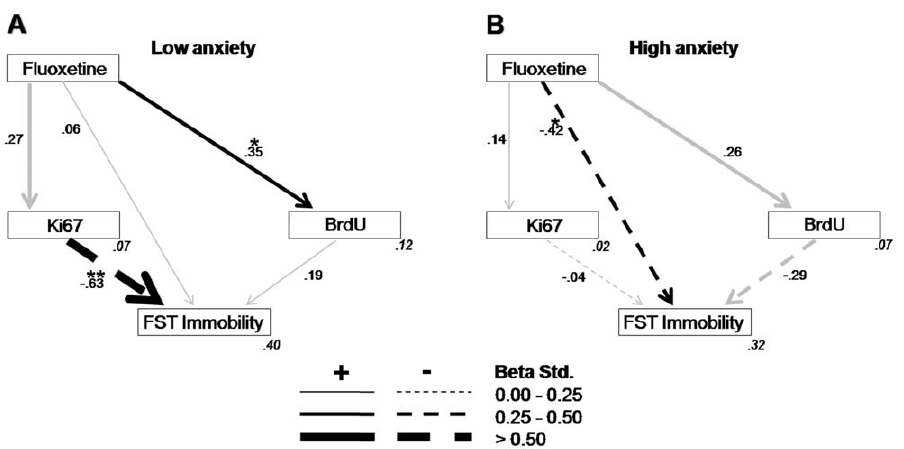
Figure 5. Path analysis for the models according to the anxiety groups. A. Model fit was tested separately for the low anxiety group ( x 2 =0.26, df=1, p=0.611; CFI=1.00; RMSEA , 0.01, p=0.621) and B. for the high anxiety group ( x 2 =0.01, df=1, p=0.924; CFI=1.00; RMSEA , 0.01, p=0.927). Significant paths (p , 0.05; **p , 0.01) are in black and non significant in gray. The squared multiple correlations ( R 2 ) of the endogenous variables are located in their right inferior corner in gray and italics.